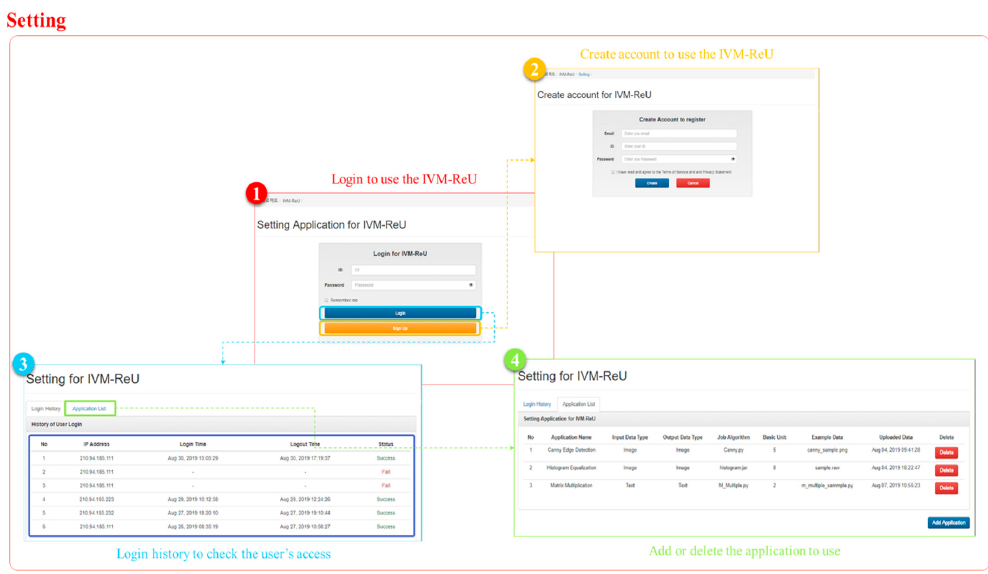
Figure 5. Setting view to register applications and users to use IVM–ReU.